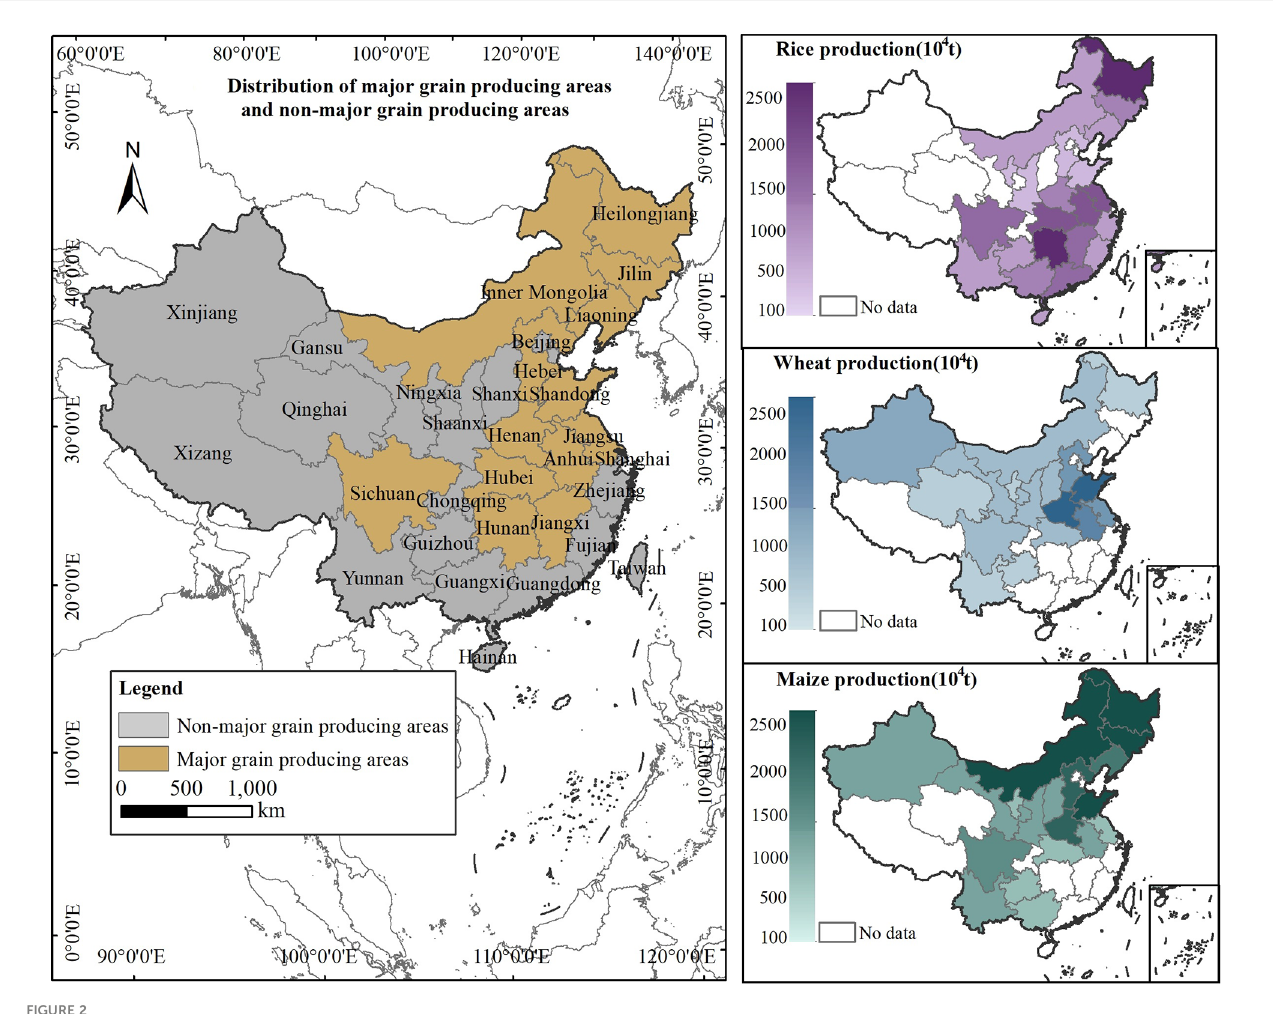
FIGURE 2 Distribution of the research